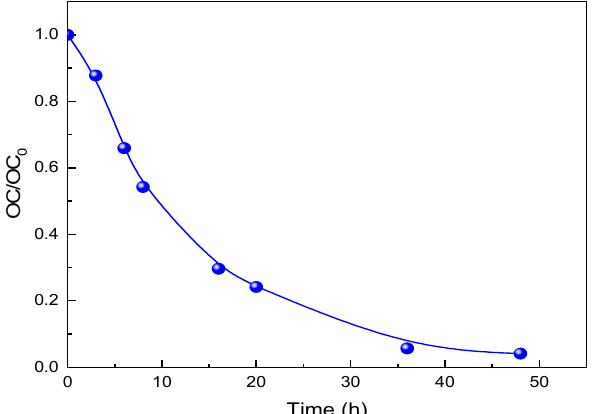
Figure 12. Organic carbon evolution during QY photocatalytic degradation in presence of Ag 3 PO 4 under UVA. [QY] 0 = 20 ppm, Ag 3 PO 4 dose = 0.5 g·L -1 and pH~7).